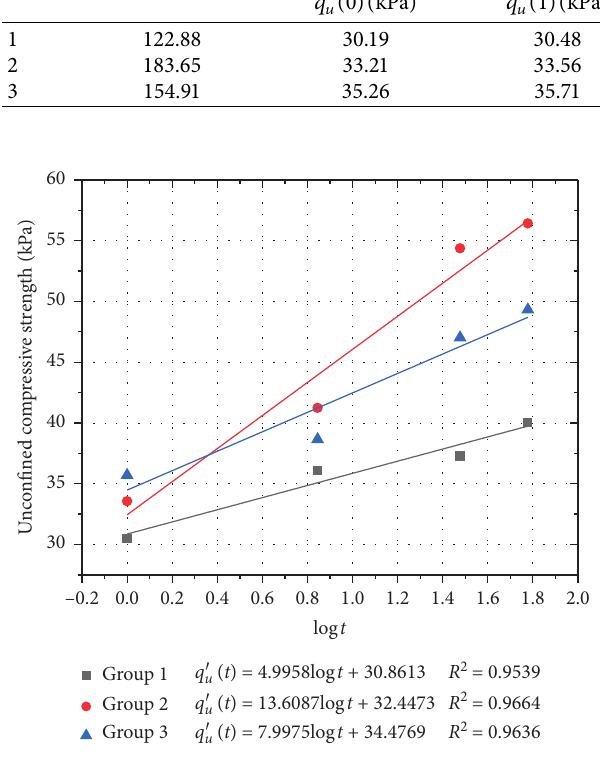
Table 2: Unconfined compressive strength test results of samples with different sensitivity at different curing times. Undisturbed soil Group sample q u ( kPa )